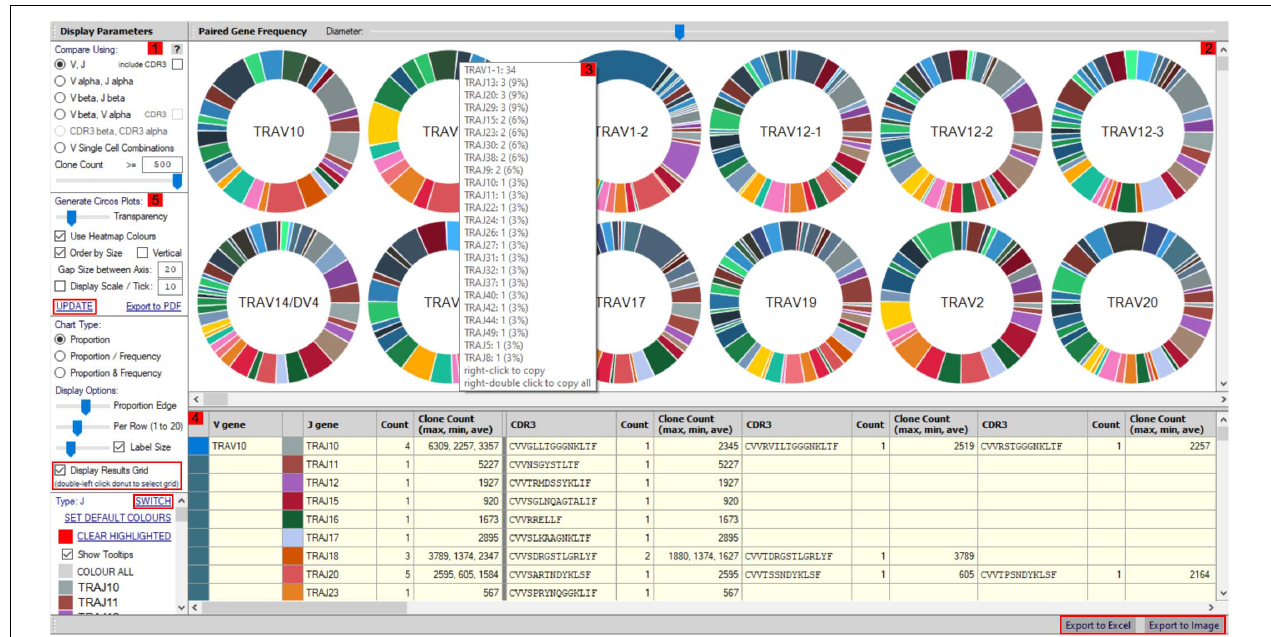
FIGURE 2 | scTCR-seq paired gene/CDR3 frequency window. The scTCR-seq analysis home screen window is divided into key domains to help direct analyses by the user. (1) Gene pairings or corresponding CDR3 sequences can be selected for analysis by the user within the “display parameters” domain. (2) Representative pie charts display proportion (and frequency) of TCR genes/CDR3 within the selected sample for initial indication of data. Each pie depicts one TCR chain with the colored border representing proportional number of pairings with corresponding chains as selected in domain 1. The central chain can be switched using “Switch” (highlighted red) in the parameters panel for alternate pairing view. (3) Hovering over select pies provides an information box with proportional representation (%) of total pairings within. (4) Paired genes are displayed in grid format by selecting “display results grid” (highlighted red), which can be exported direct to Excel or Image (highlighted red). (5) Circos plots can be generated for selected samples/pairings by clicking “Update” (highlighted